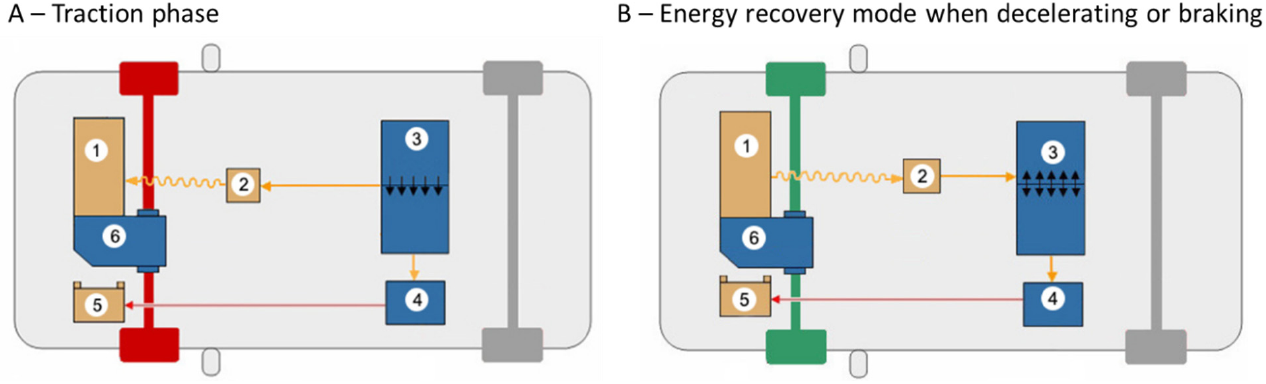
Figure 10. Drive train operating modes while driving ( ① —electric drive motor, ② —inverter, ③ — traction battery, ④ —on-board charger/DC-DC voltage transformer, ⑤ —ancillary battery, ⑥ —re- duction gear) [32].